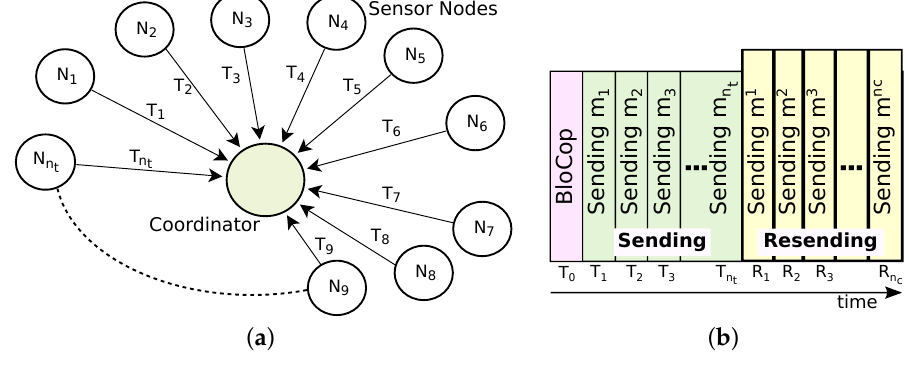
Figure 2. Star topology communication model. ( a ) Messaging model; ( b ) Message